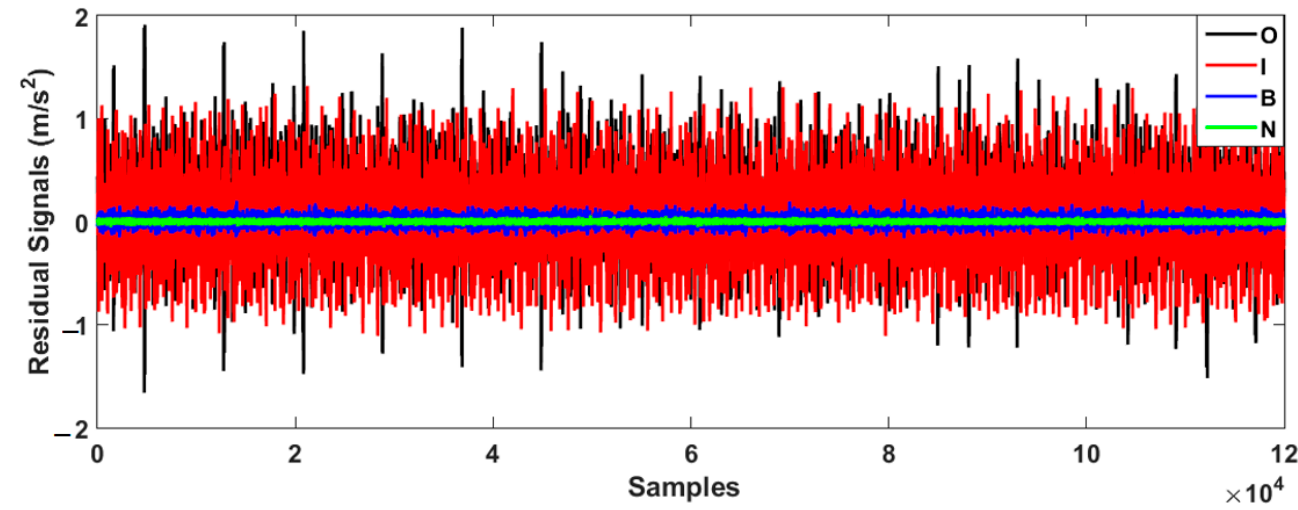
Figure 7. Bearing residual signals using the FVS approach.